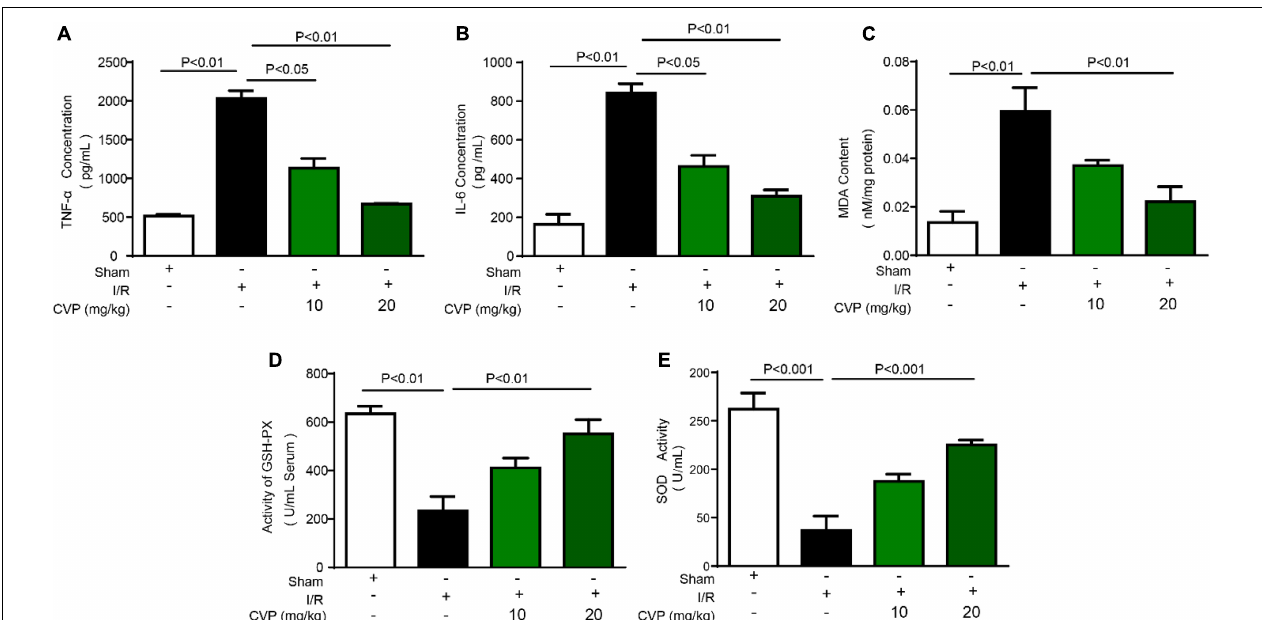
FIGURE 4 | Chuanminshen violaceumis polysaccharide (CVP) inhibited oxidative stress and inflammation response in I/R mice. After serum was collected from the abdominal aortic artery, levels of pro-inflammatory cytokines TNF- α (A) and IL-6 (B) were detected with ELISA kits, oxidative stress markers MDA (C) , GSH-PX (D) , and SOD (E) were evaluated by biochemical detection of serum. CVP, Chuanminshen violaceumis polysaccharides; GSH-PX, glutathione peroxidase; IL-6, interleukin-6; I/R, ischemia-reperfusion; MDA, malondialdehyde; SOD, superoxide dismutase; TNF- α , tumor necrosis factor- α .